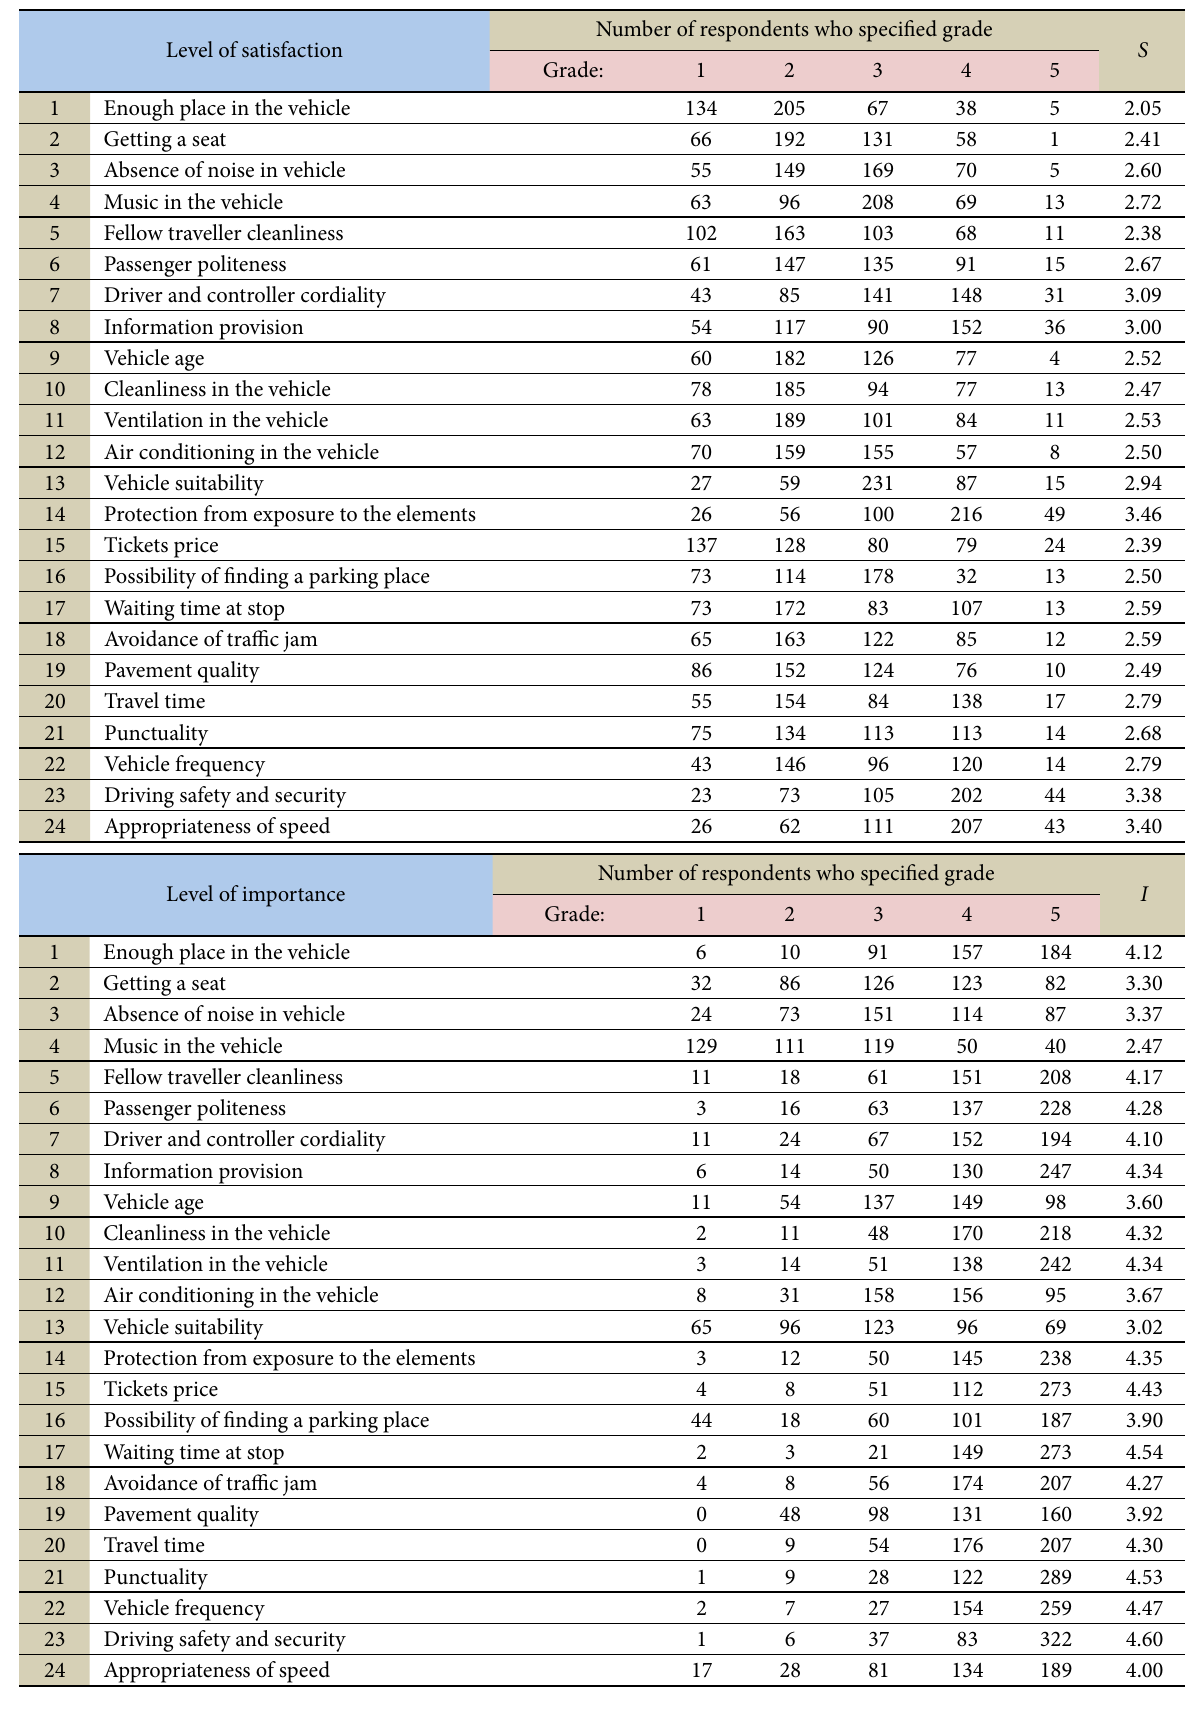
Table 1. Level of satisfaction and importance of service quality